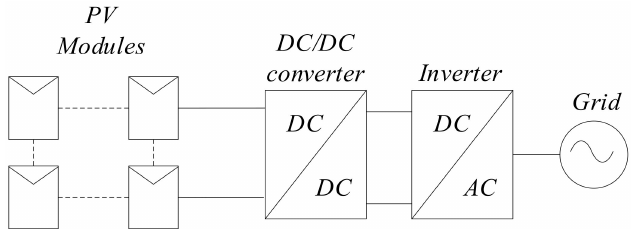
Figure 1. Centralized structure of the grid-connected photovoltaic systems.